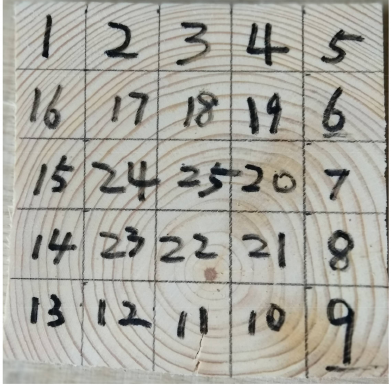
Figure 3. The test piece of the moisture content and decomposition sample